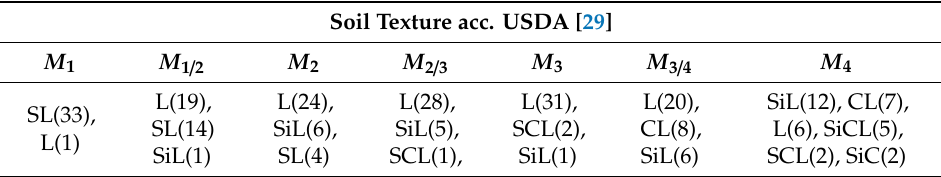
Table 6. Soil texture for the particular data subsets (Mx) , obtained after grouping with combination number 9 (see Table